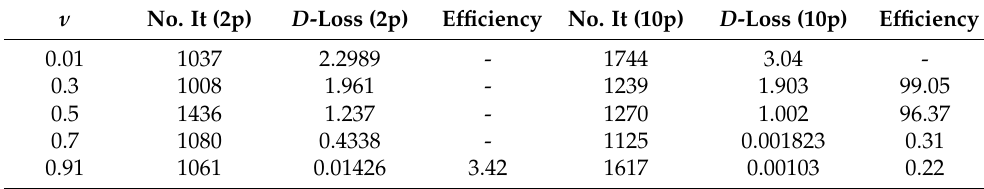
Table 5. Number of iterations needed for achieving the D -optimal robust designs computed in Tables 1 and 2, their corresponding loss function values and efficiencies.